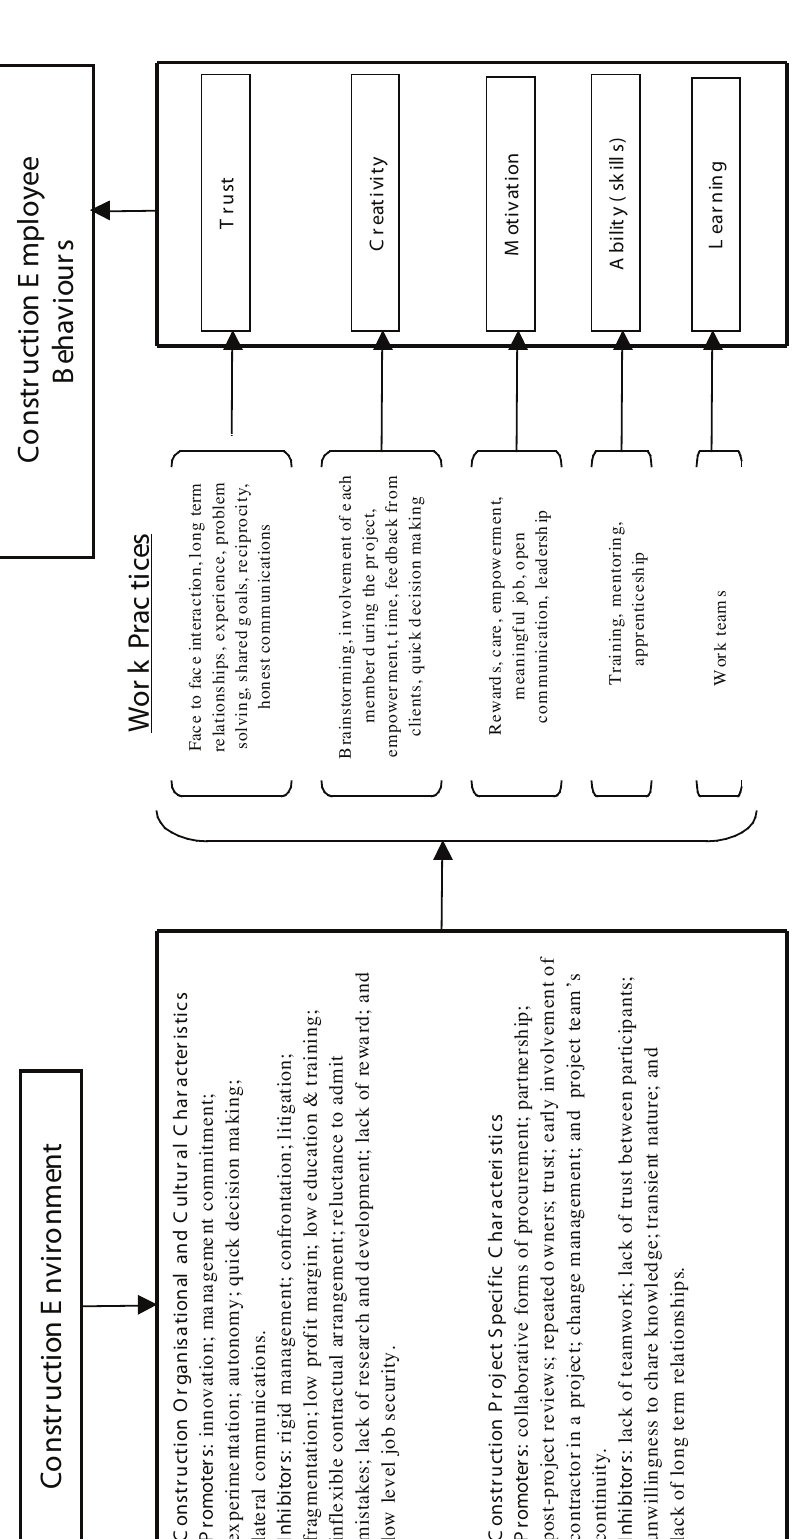
Figure 3: Parameters that influence tacit knowledge in